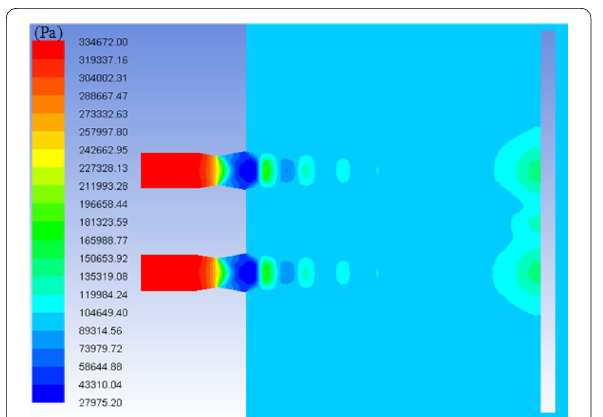
Figure 16 Total pressure contour of gas jet from twin engines